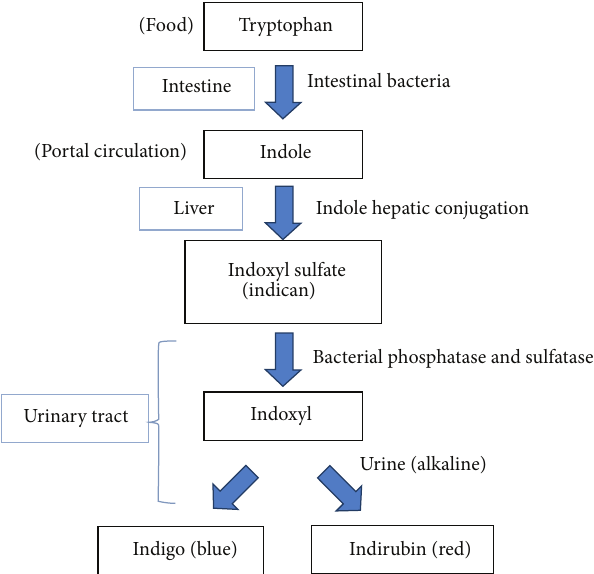
Figure 3: Pathogenesis of PUBS (with courtesy of Hadano et al.